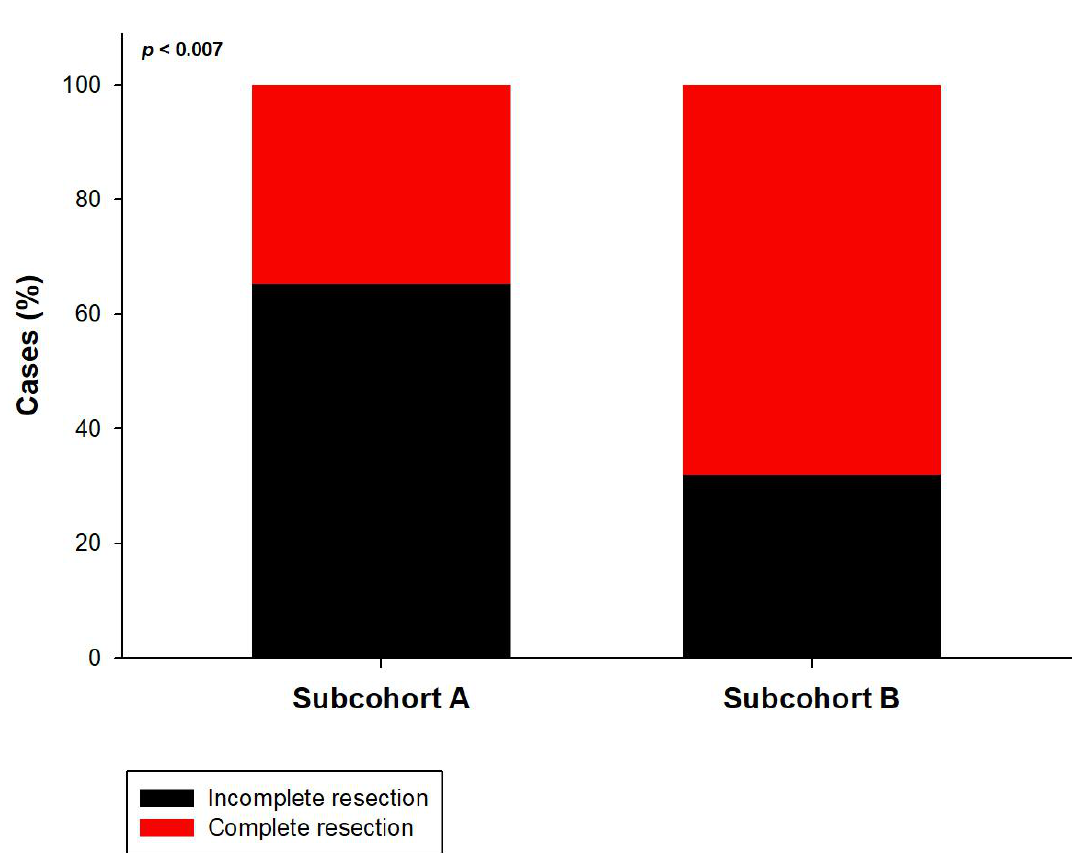
Figure 2. Impact of the NOC (neuro-oncology care center) foundation on the quality of resection: Subcohort ( B ) treated after the NOC foundation showed a significantly higher proportion of complete resections compared to subcohort ( A ) treated before NOC foundation.